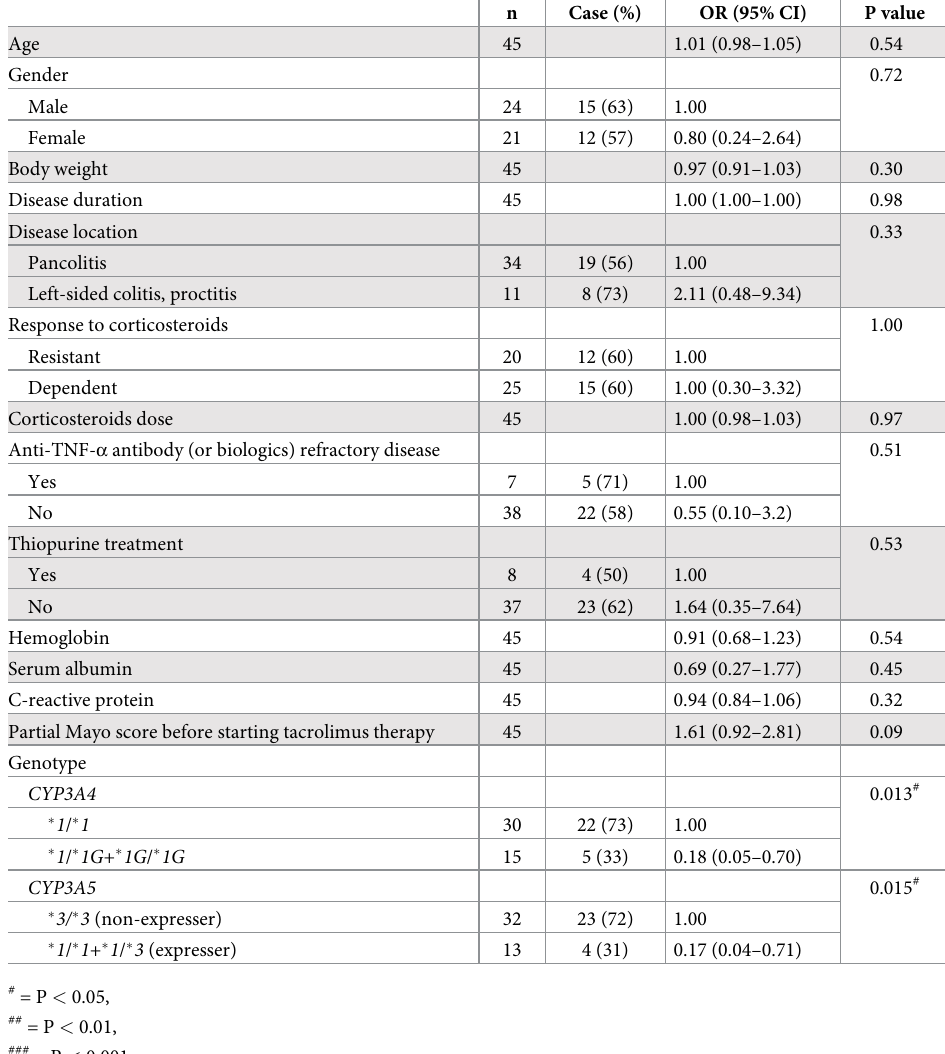
Table 4. Univariate analysis of factors associated with efficacy at 1 week after tacrolimus